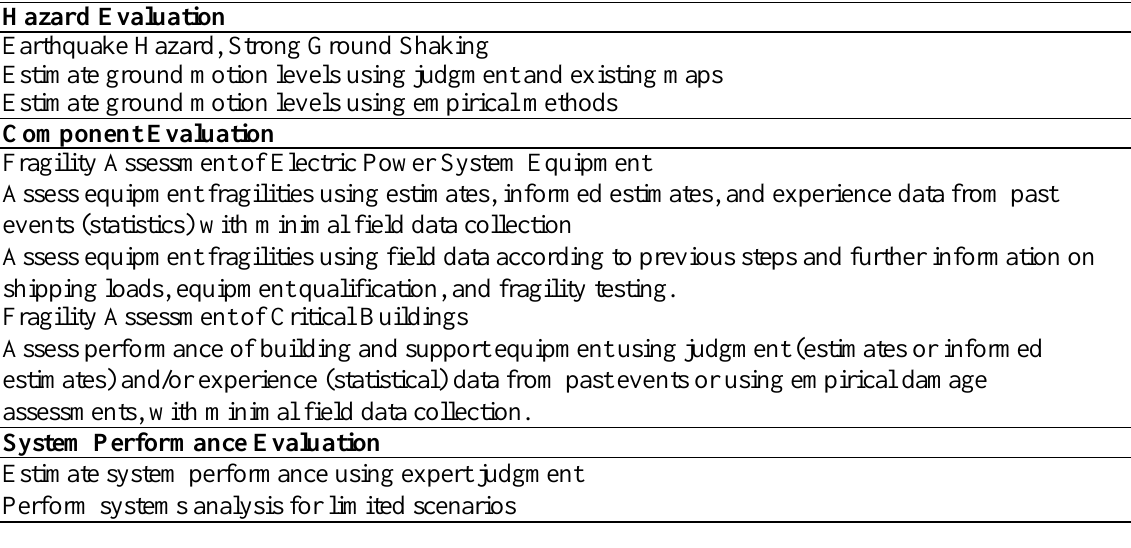
Table 9. Hazard, Component and System Performance Evaluation Matrix for 63 KV power substations of Qazvin - Earthquake Hazard of the studied area